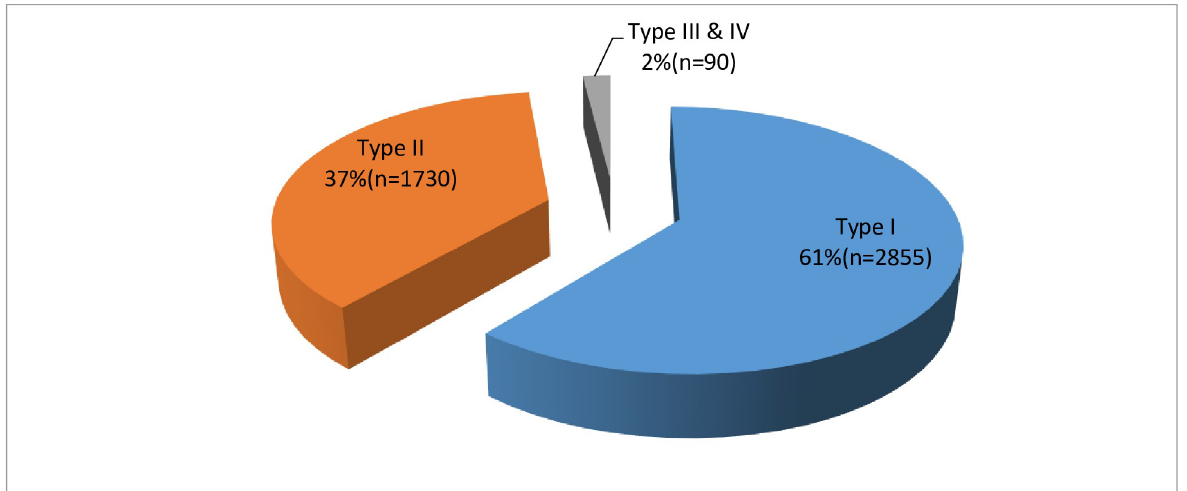
Fig 2. Proportion of female genital mutilation by type.